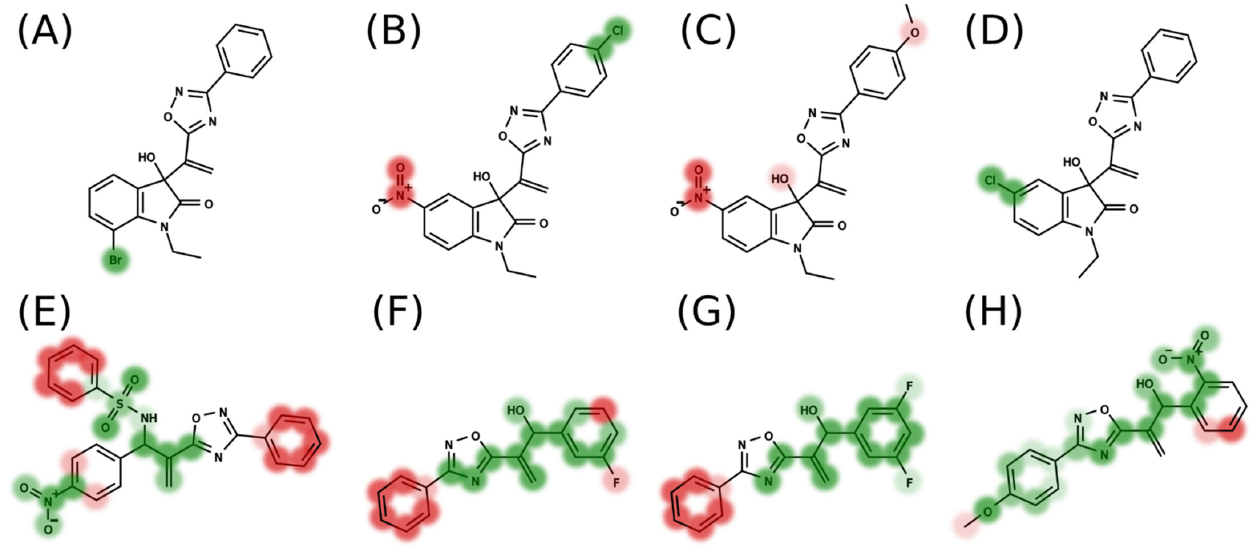
Figure 4. Contribution map generated by KPLS of groups G 1 ( A – D ) and G 2 ( E – H ). Green colors represent positive contributions, and red colors indicate negative contributions to biological activity.